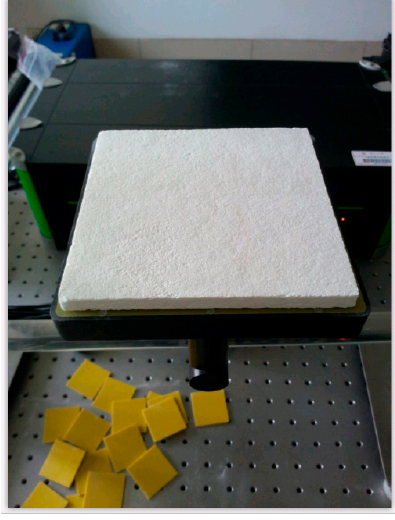
Figure 2. The sample without adhesion.